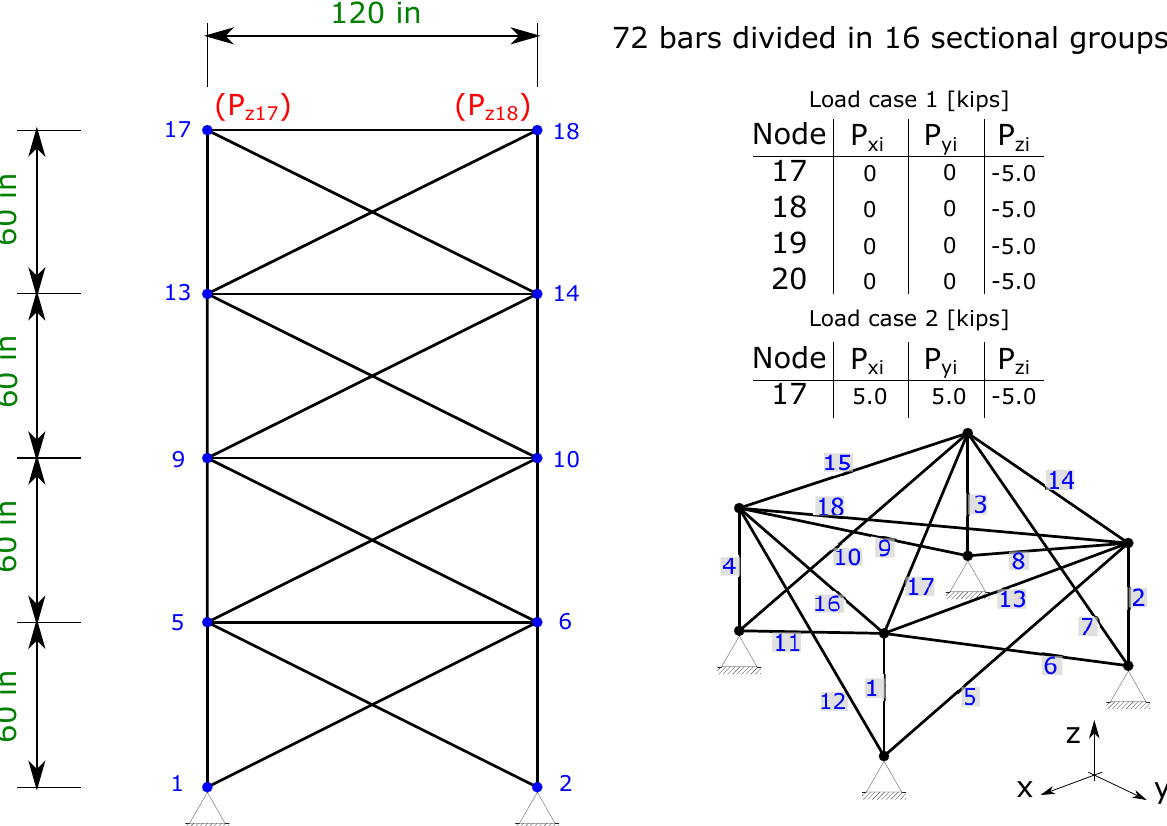
Figure 9. Graphical representation of the seventy-two bars truss design optimization